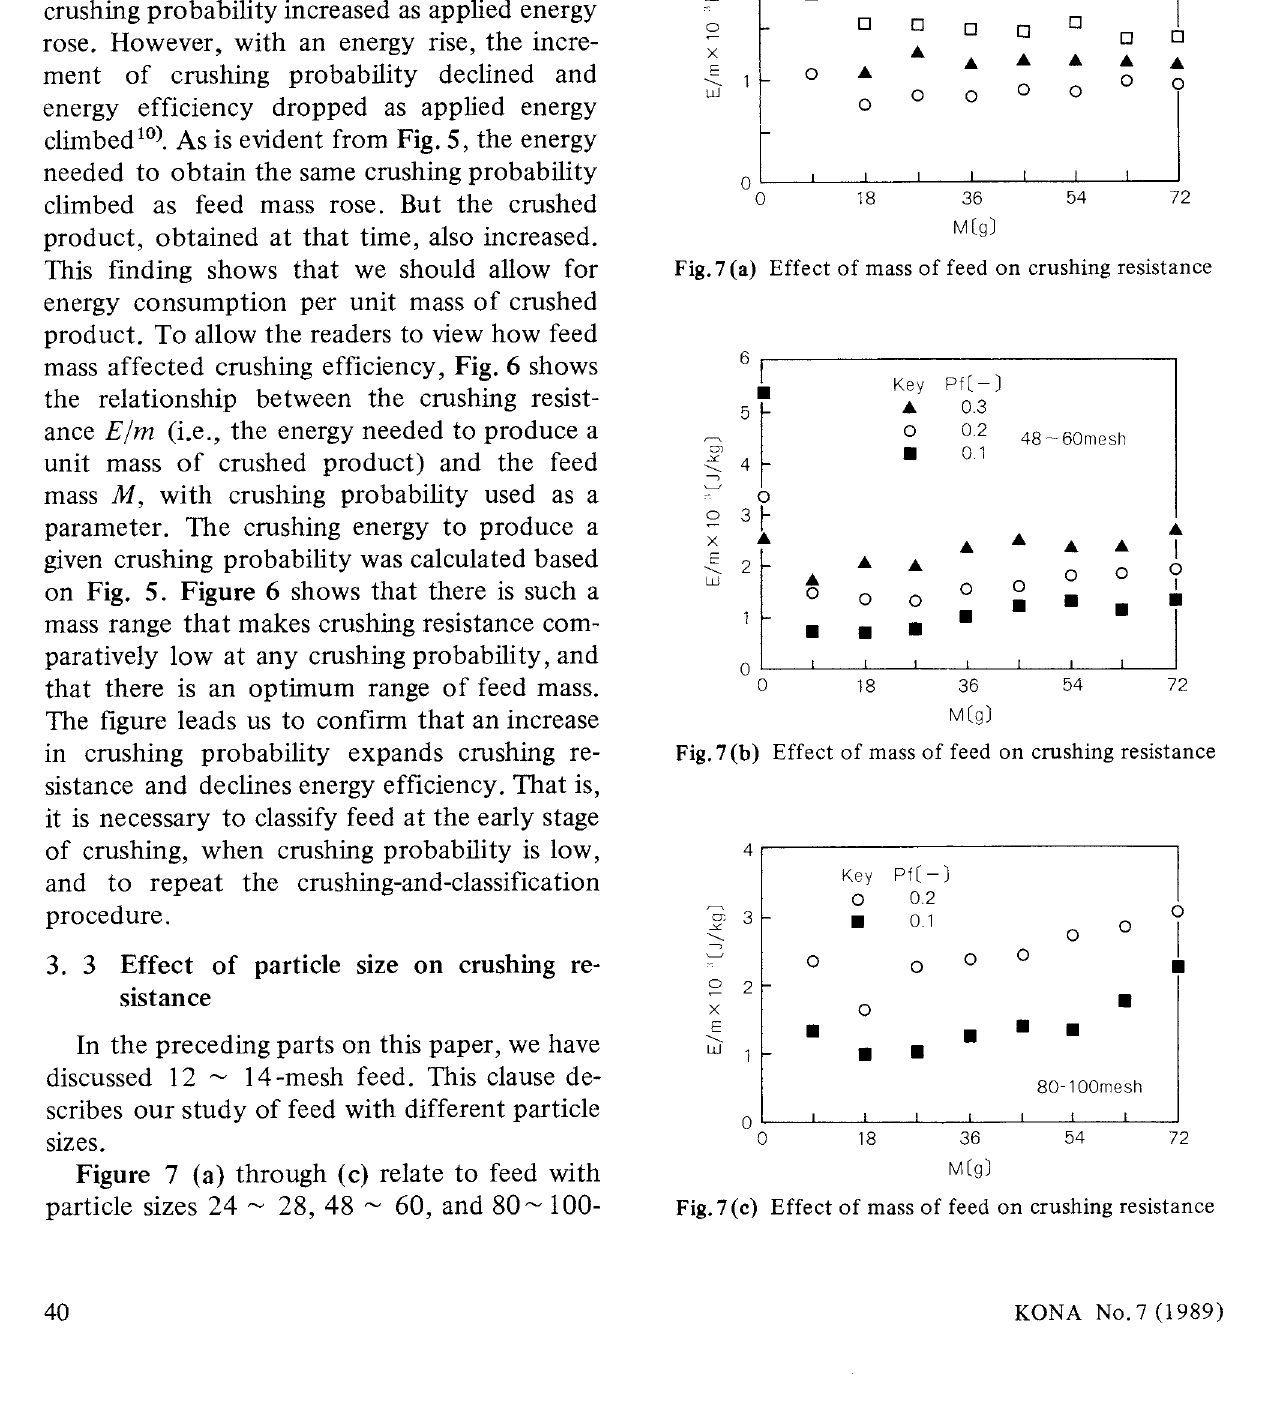
Fig. 6 Effect of mass of feed on crushing resistance